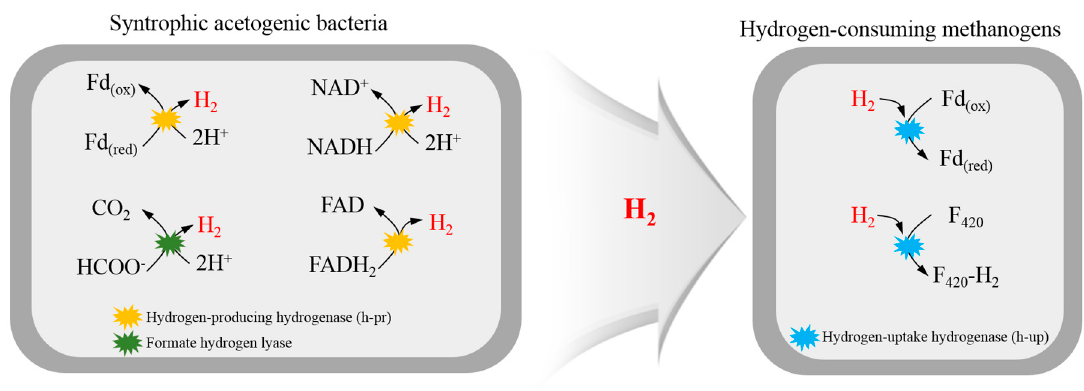
Figure 1. Interspecies hydrogen transfer and intracellular redox mediators for hydrogen consumption and production.